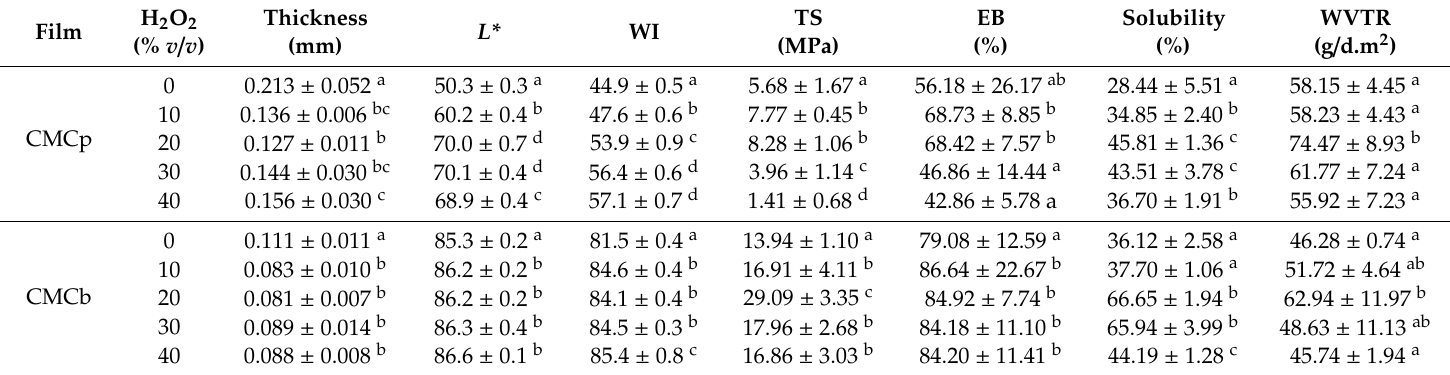
Table 2. Physical properties of the films from CMCp and